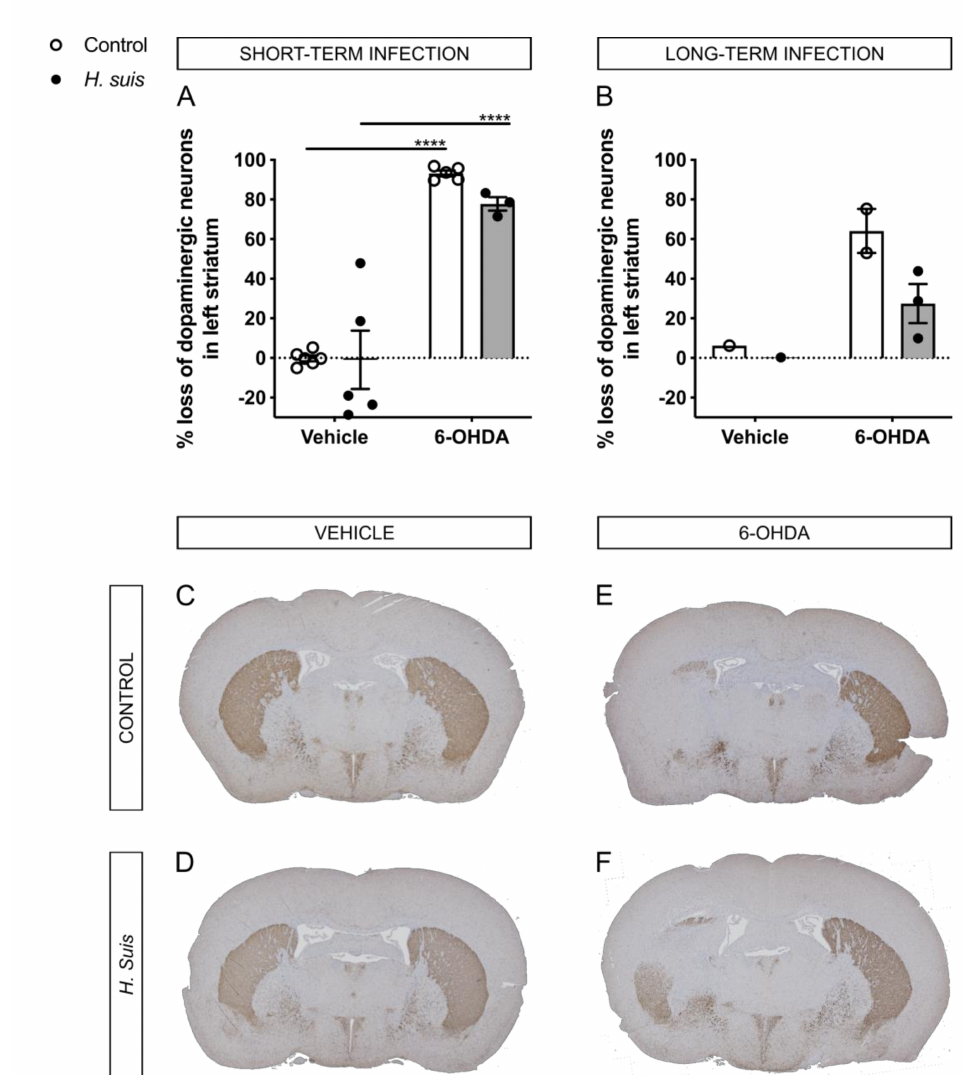
Figure 5. Helicobacter suis ( H. suis )-infected mice are partially protected against the loss of dopaminer- gic neurons induced by intrastriatal 6-hydroxydopamine (6-OHDA) injection. ( A , B ) Loss of dopamin- ergic neuron fiber density in the left compared to the right striatum based on tyrosine hydroxylase (TH) staining, 7 days after intrastriatal injection with either 6-OHDA (n = 2–5) or vehicle (n = 1–6), of mice infected with H. suis (black) or the control broth (white) for a short- ( A ) or long-term period ( B ). ( C – F ) Representative whole-brain section images of the tyrosine hydroxylase staining (brown) for dopaminergic neuron fiber density in the striatum of mice from a control/vehicle subgroup ( C ), H. suis/ vehicle subgroup ( D ), control/6-OHDA subgroup ( E ), and H. suis /6-OHDA subgroup ( F ). **** p <